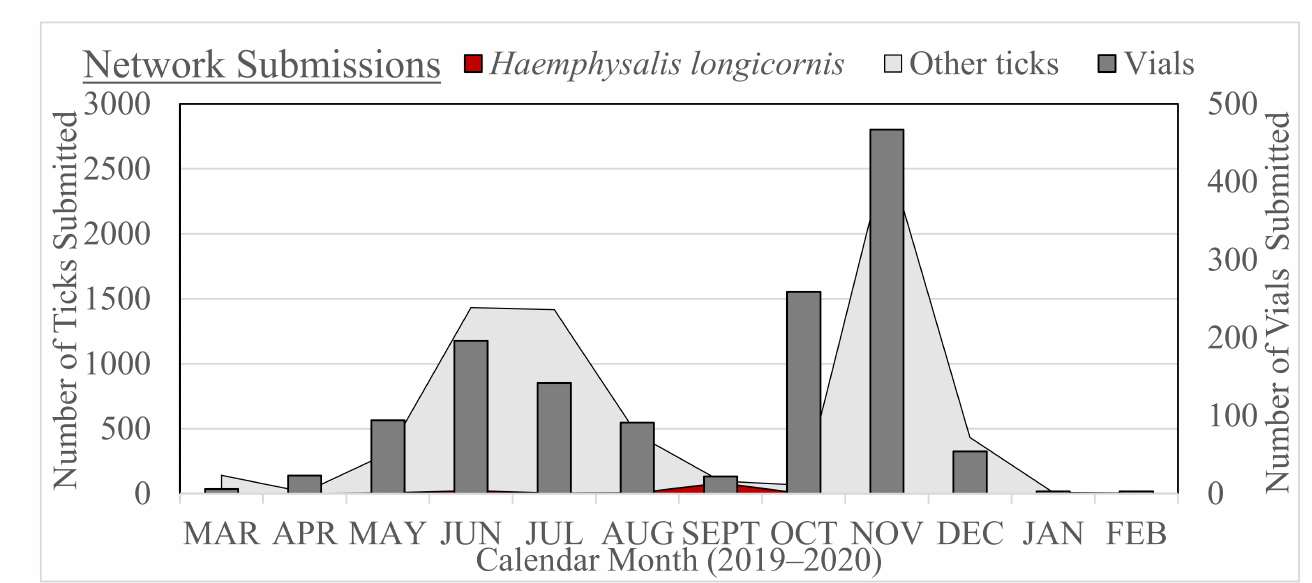
Figure 1. Seasonal distribution of Haemaphysalis longicornis (red) and other ticks (light gray) received at University of Tennessee from statewide cooperating network collectors (dark gray), 2019–2020.